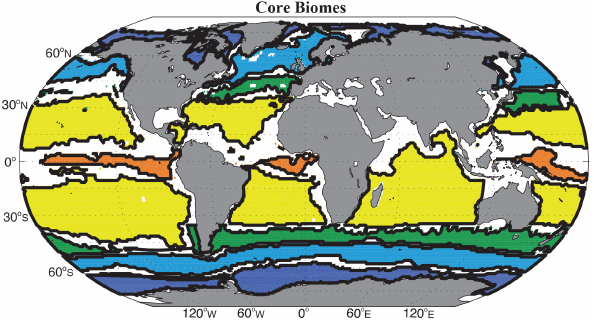
1998 1999 2000 2001 2002 2003 2004 2005 2006 2007 2008 2009